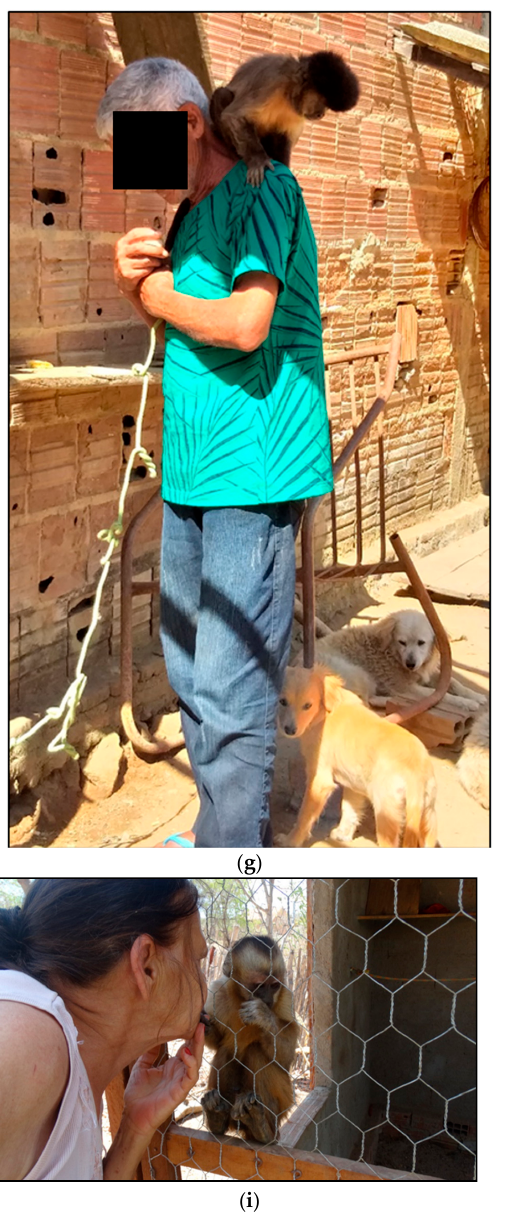
Figure 6. Examples of contact of wild animals with domestic animals and the population: ( a ) monkey living in the same environment as domestic dogs and cats; ( b ) domestic dog ( Canis familiaris) and domesticated wild canid ( Cerdocyon thous ) living in the same environment; ( c ) human contact with marmosets in backyard; ( d ) human contact with monkey in backyard; ( e , f ) human contact with marmoset. ( g – j ) nail monkey breeders in contact with the animals.